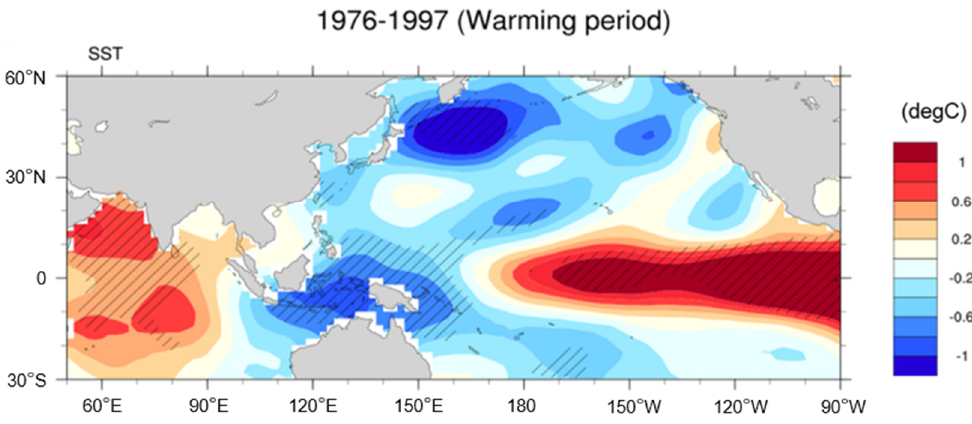
Figure 13. Composite anomalies of SSTs of dominate positive and negative years of EOF2 during the warming period according to Table 2. Table 2. Dominant positive and negative years of EOF2 during the warming and hiatus periods.